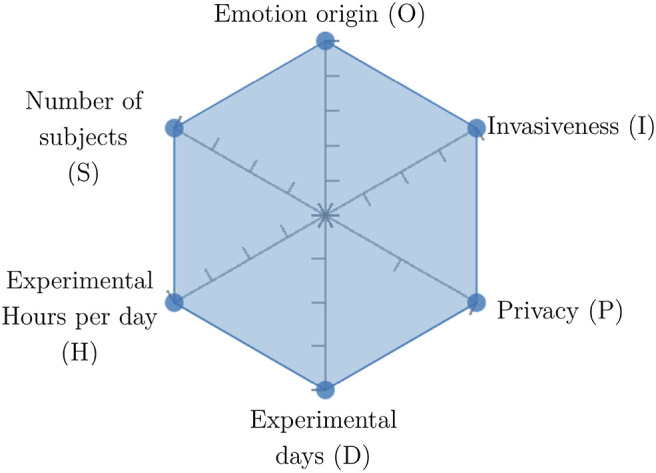
The GARAFED method.